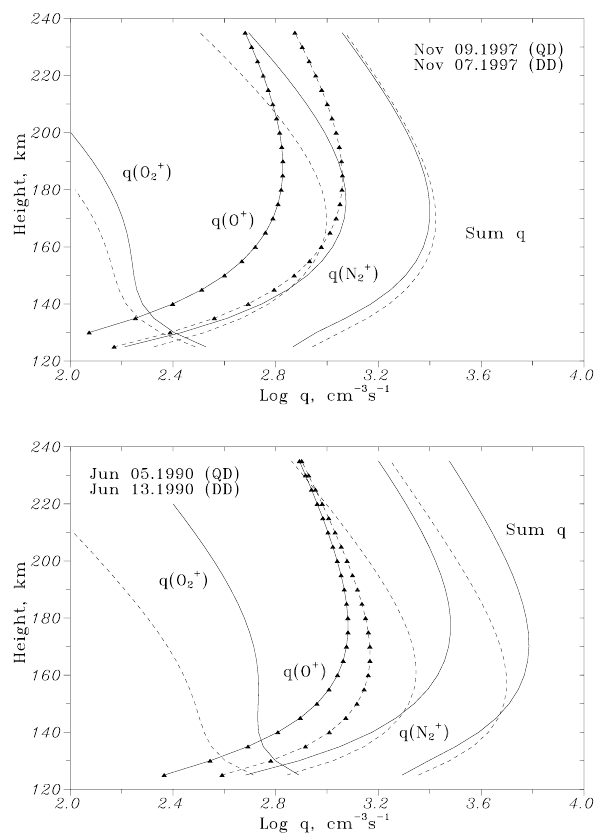
Fig. 5. Calculated ion production rates for the analyzed distur- bances. Again solid lines refer to disturbed